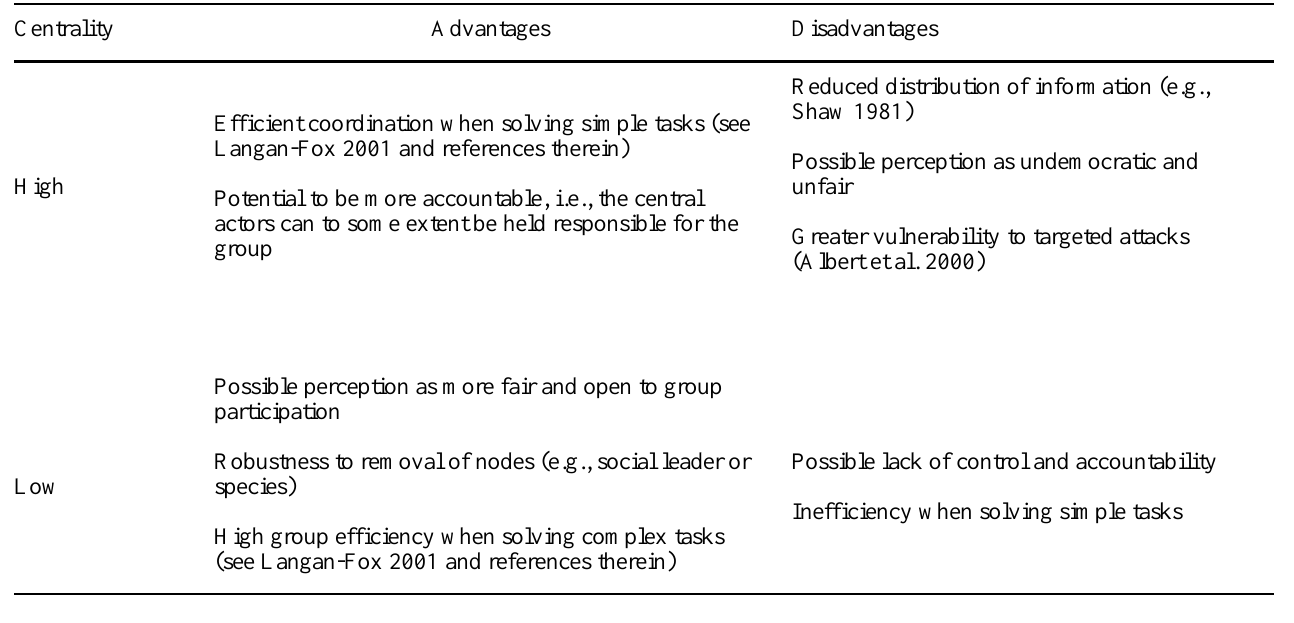
Possible lack of control and accountability Inefficiency when solving simple